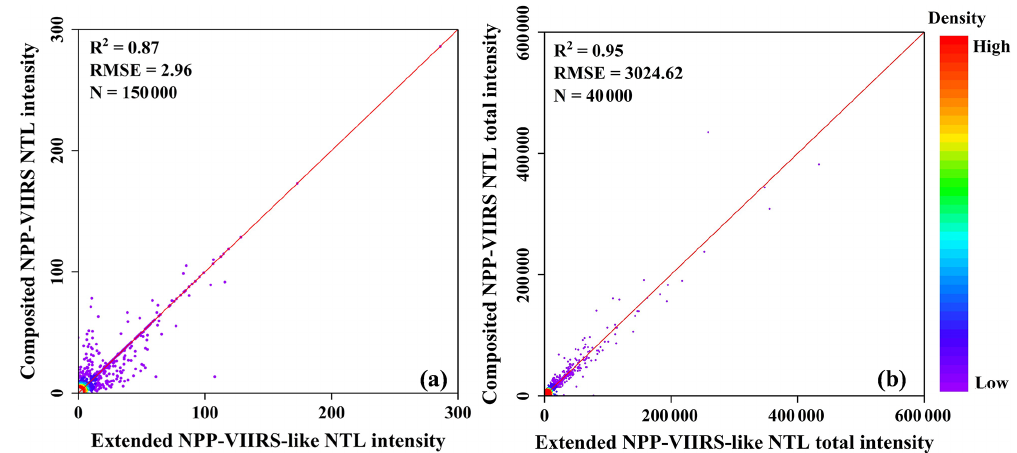
Figure 5. The comparison with kernel density between the global composited NPP-VIIRS NTL data and extended NPP-VIIRS-like NTL data in 2012 (unit: nWcm − 2 sr − 1 ) (a) at the pixel and (b) city levels. The solid line denotes the 1 : 1 line, and N is the number of sample points